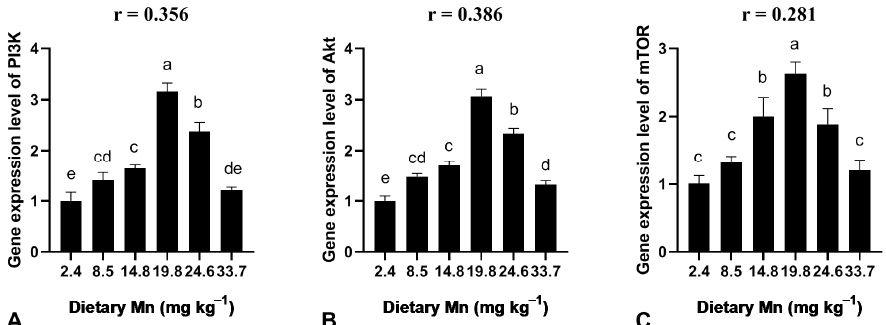
Figure 4. Effect of dietary Mn on the gene expression level in the liver of post-larval coho salmon. ( A ) PI3K; ( B ) Akt; ( C ) mTOR. Data were expressed by mean ± SE ( n = 3). One-way ANOVA followed by Tukey HSD was used to determine whether Mn levels significantly ( p < 0.05) affected the observed responses. The different superscript letters are significantly different ( p < 0.05). In addition, a two-tailed Pearson Correlation test was used to determine the correlation between dietary Mn levels and the values of gene expression levels. Abbreviations: phosphatidylinositol 3-Kinase (PI3K), protein kinase B (Akt), mammalian target of rapamycin (mTOR).